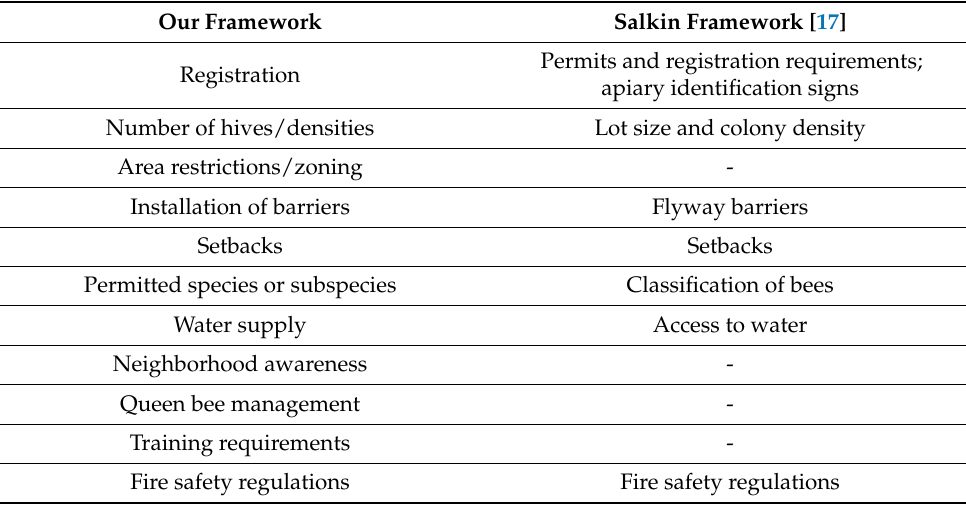
Table 3. Relationship between our framework and previous study for regulatory objectives. Our